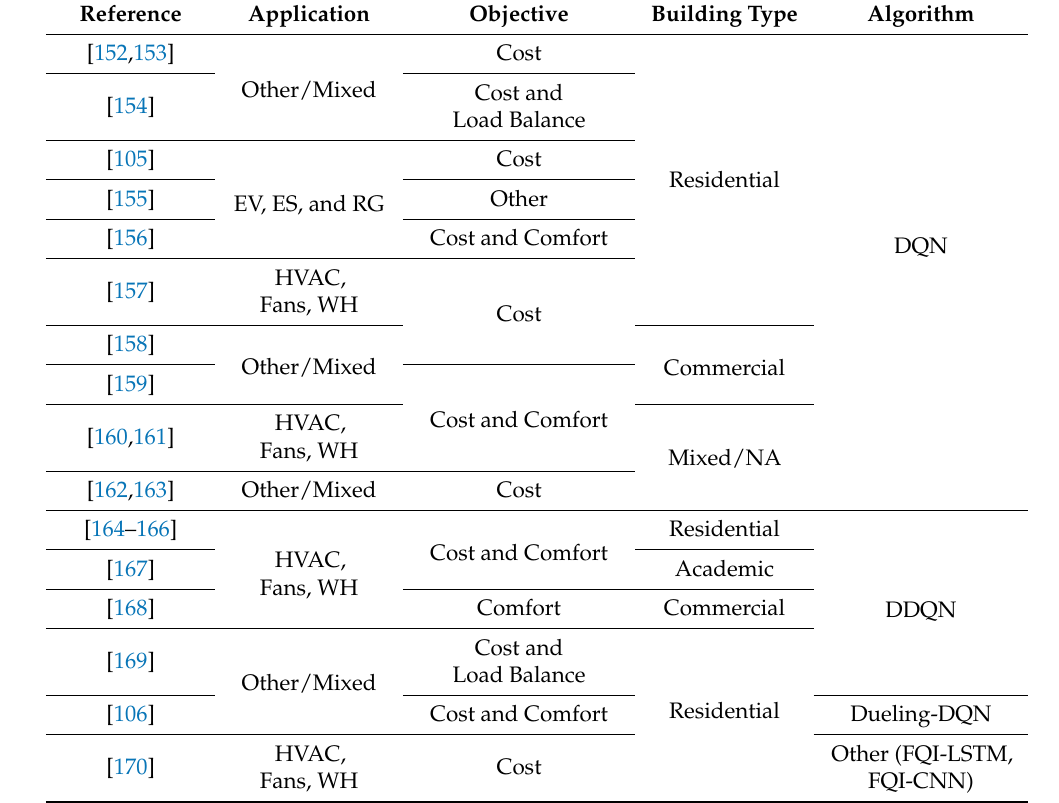
Table 2. References using Deep Q Networks.